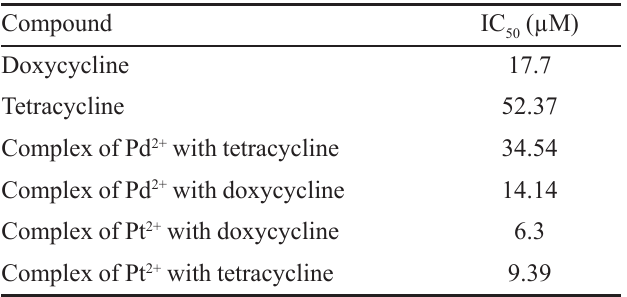
values for complexes of palladium (Pd) and TABLE III - IC 50 platinum complexes (Pt) (Rocha et al. , 2011)